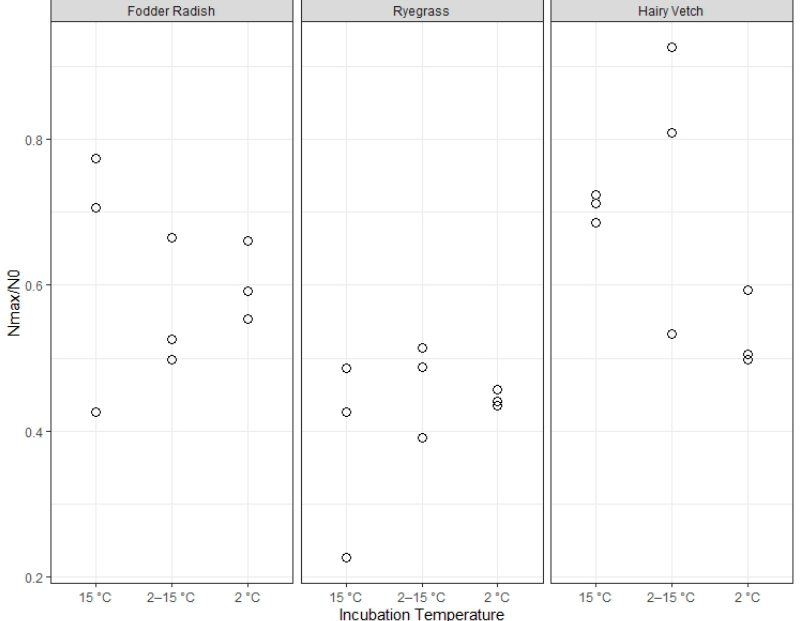
Figure 3. Final net plant residue N mineralization as fractions of total added residue N ( N max /N 0 ). Dots ( ○ ) represent individual soil core samples, incubated in triplicates at high and low constant temperatures as well as variable temperature, with three types of catch crop residue. Mean background net N mineralization from control samples (no plant residue) was subtracted.